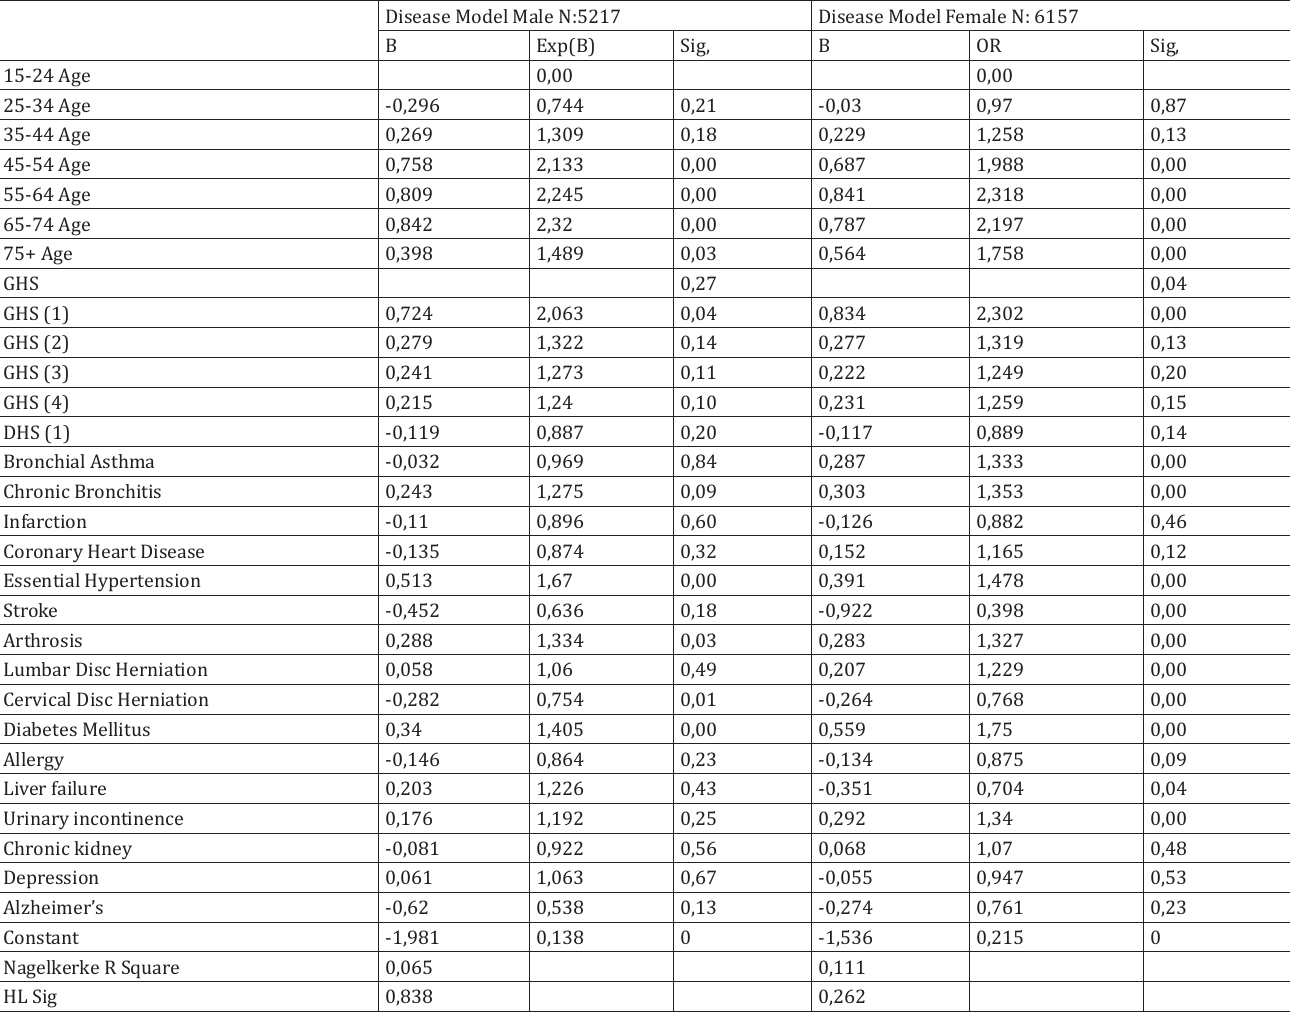
Table 4 Disease Model Male and Female Distinction